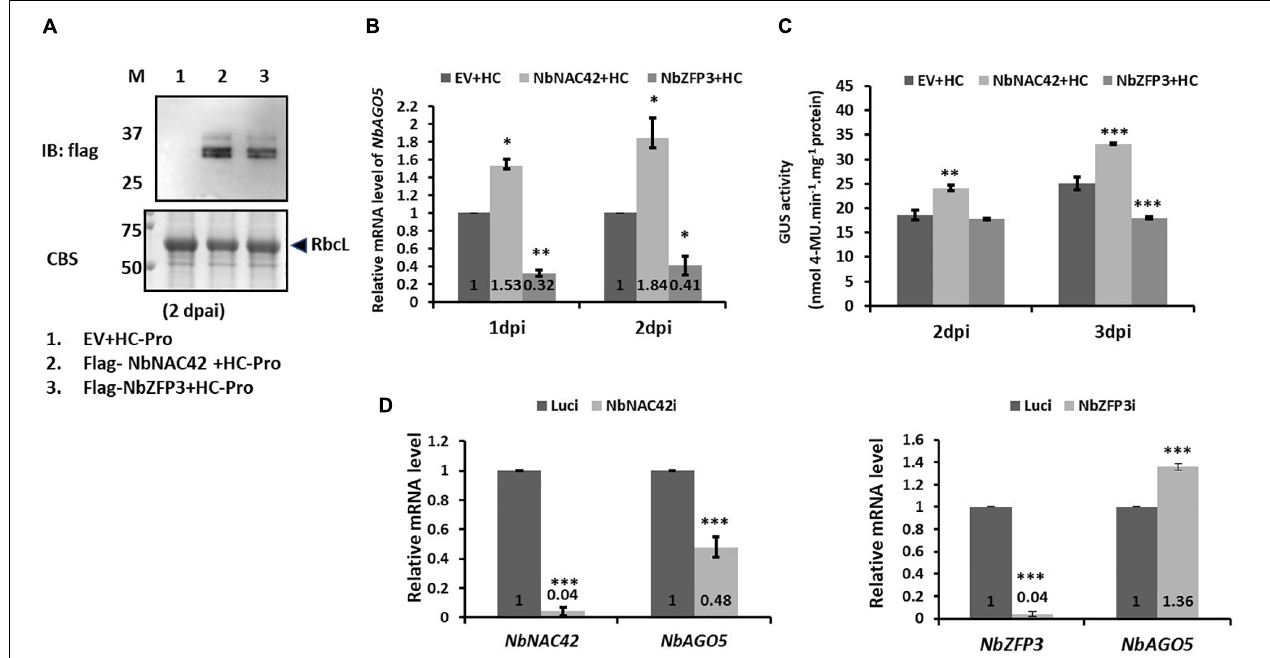
FIGURE 6 | Effects of overexpression and silencing of NbNAC42 and NbZFP3 on NbAGO5 levels in N. benthamiana . (A) Immunoblot analysis using anti-Flag antibody confirmed the expression of Flag-tagged NbNAC42 and NbZFP3. Total protein extracts were prepared from N. benthamiana leaves at 2 days post-agroinfiltration (dpai) and underwent SDS-PAGE, followed by Coomassie blue staining (CBS), anti-Flag immunoblotting. M, prestained protein markers on the left with molecular mass (in kDa). RbcL, RuBisCO large subunit is the loading control. (B) The expression level of NbAGO5 was analyzed by qRT-PCR. (C) The effects of NbNAC42 and NbZFP3 on PN4 activity. The GUS expression level of PN4 transgenic N. benthamiana plants transiently expressed NbNAC42 and NbZFP3 by Agrobacterium-mediated expression was analyzed at 2 and 3 dpi. (D) The transcript level of NbAGO5 in N. benthamiana transiently knock-down the expression of NbNAC42 and NbZFP3 . Statistical significance was analyzed using two-tailed student’s t -tests; * p < 0.05; ** p < 0.01; *** P <